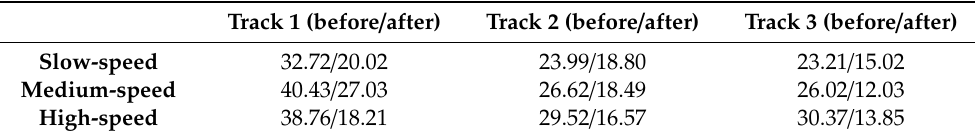
Table 3. The percentage (%) of the abnormal positioning with errors greater than 50 cm.